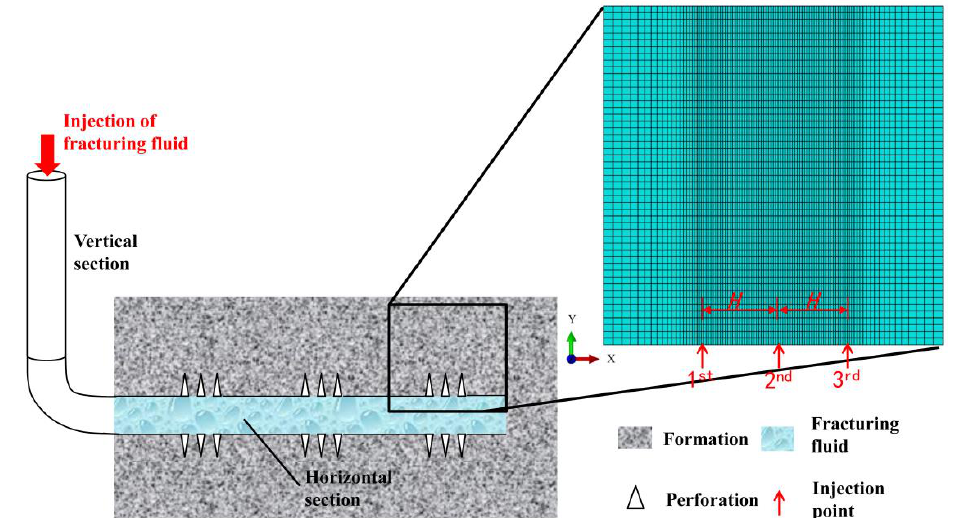
Figure 2: Schematic diagram of multi-cluster staged fracturing for shale gas horizontal well and the established finite element model Two types of elements, CPE4P and COH2D4P, are used in the model. The CPE4P element can simulate the plane strain